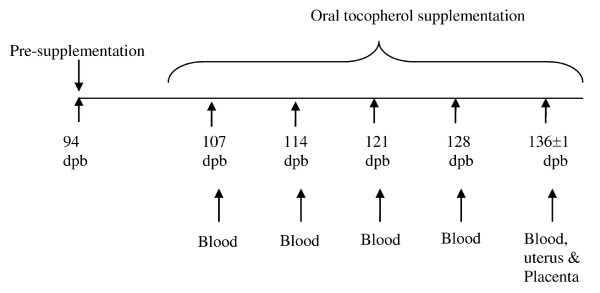
Schematic representation of treatment regimen and sample collection. dpb - days post breeding.